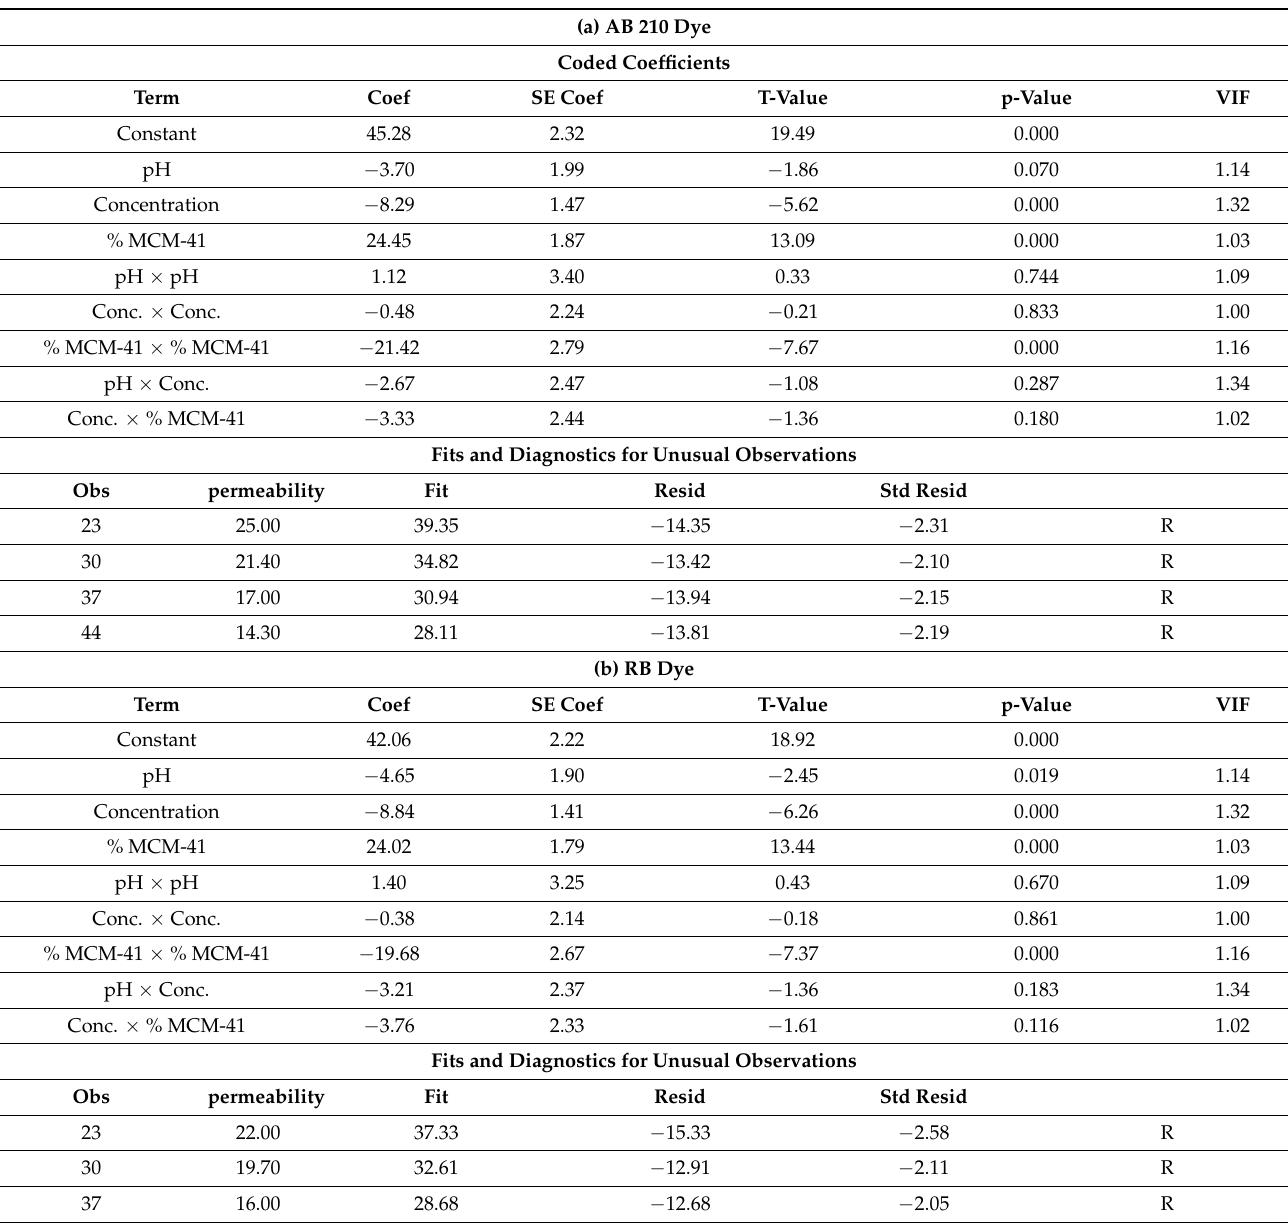
Table 5. ANOVA for the membrane permeability of (a) AB-210, and (b) RB